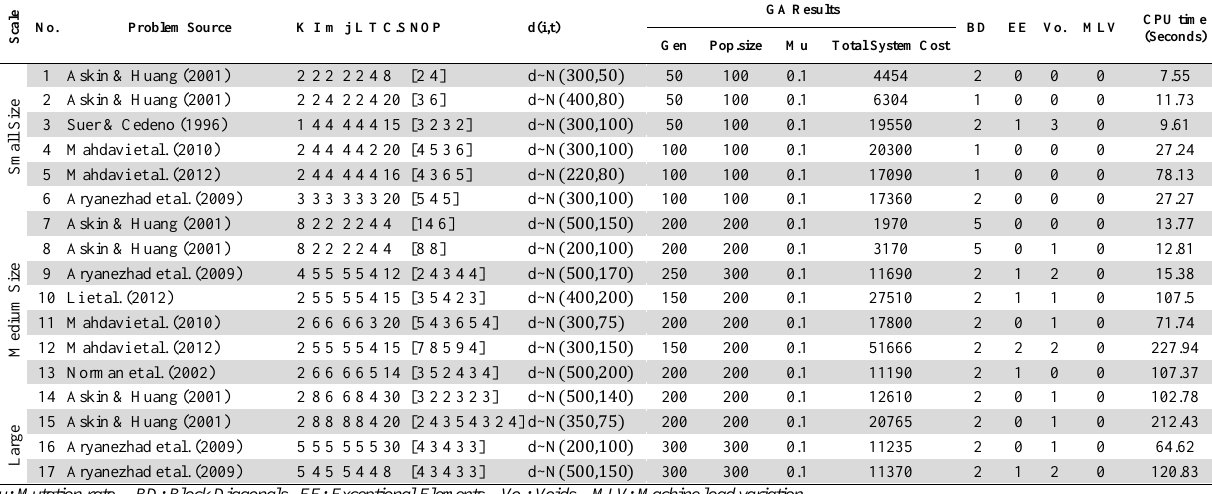
Mu: Mutation rate BD: Block Diagonals EE: Exceptional Elements Vo.: Voids MLV: Machine load